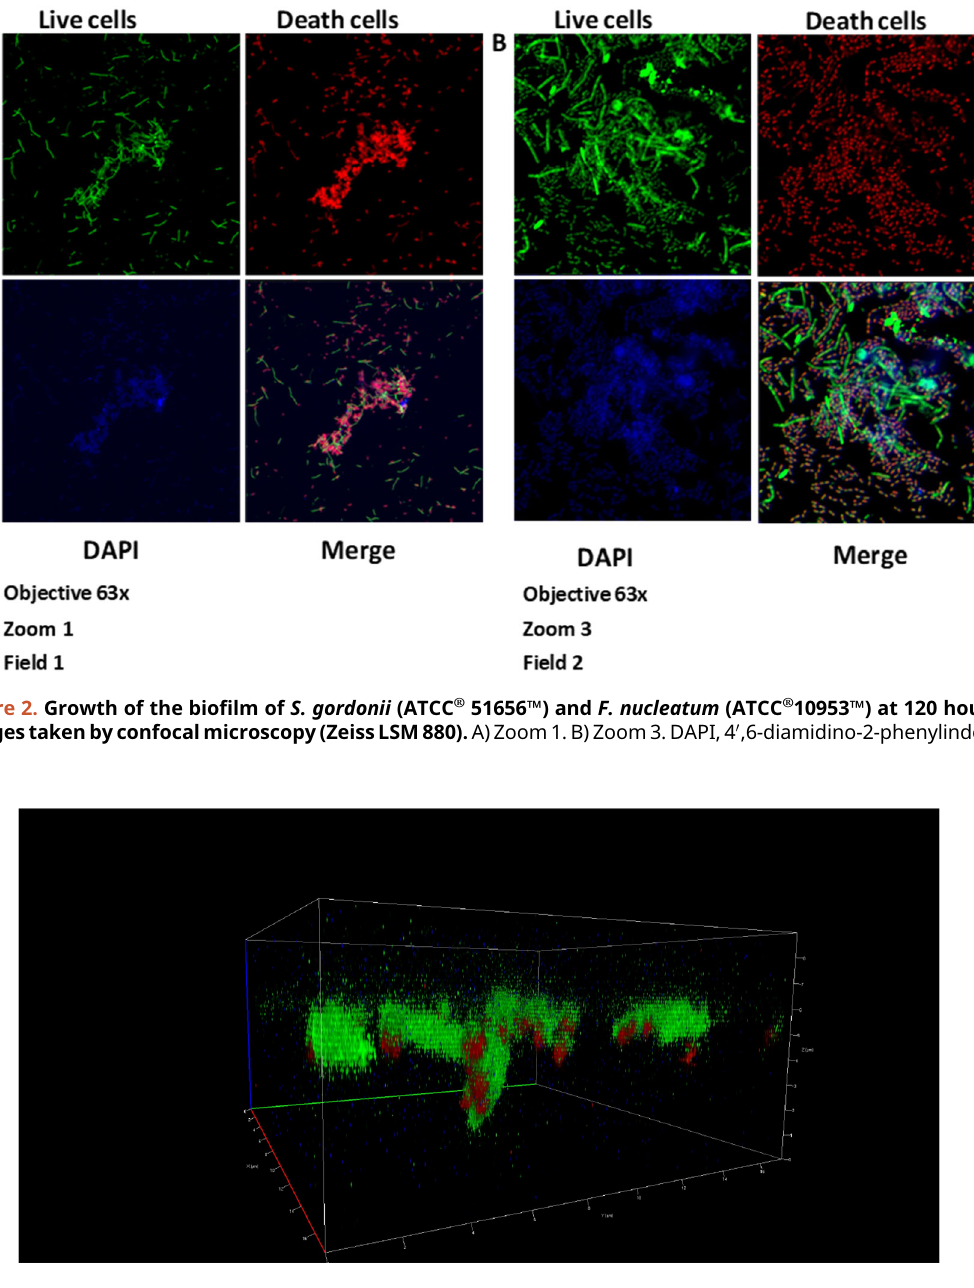
Figure 3. Vertical growth of the biofilm of S. gordonii (ATCC ® 51656 ™ ) and F. nucleatum (ATCC ® 10953 ™ ) at 120 hours. Images taken by confocal microscopy (Zeiss LSM